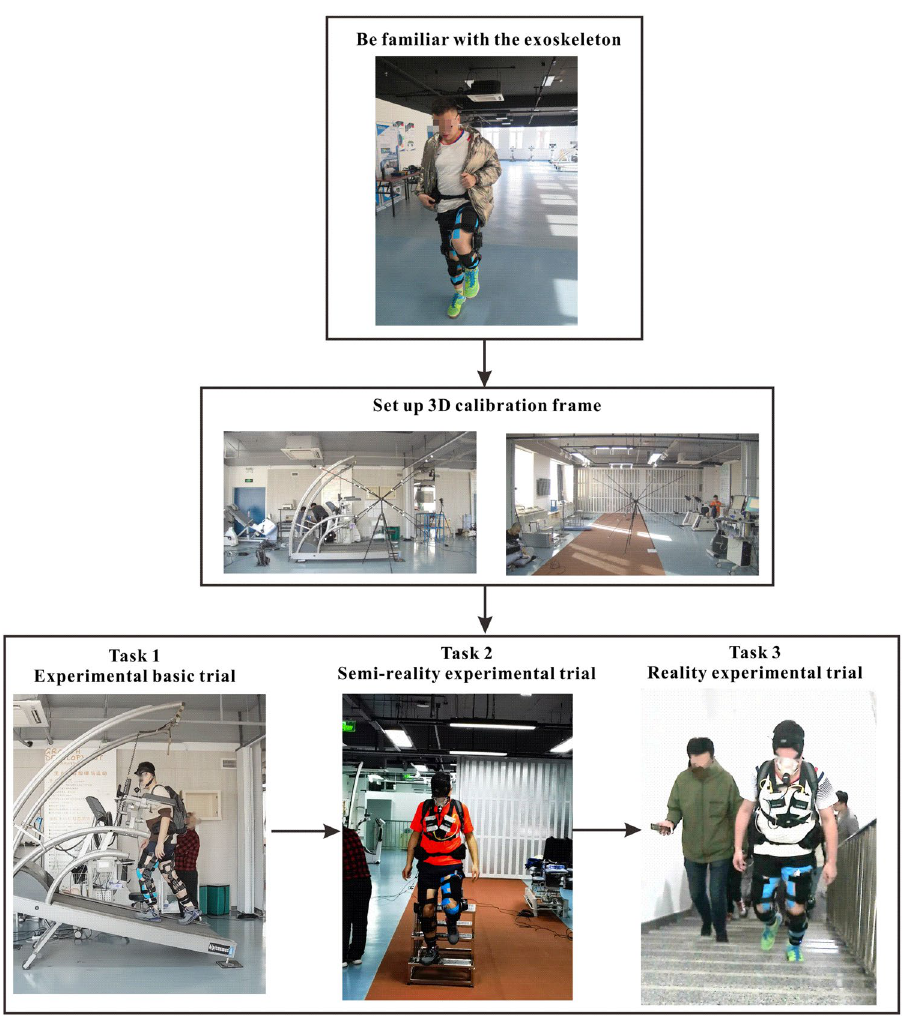
Figure 3. Performance test of the APAK exoskeleton. First, the subject should be familiar with the tested exoskeleton; second, a 3D calibration frame is set up. Finally, walking on treadmill at certain degree, walking up and down on three-step stairs, and ascending 11-storey stairs are carried out.